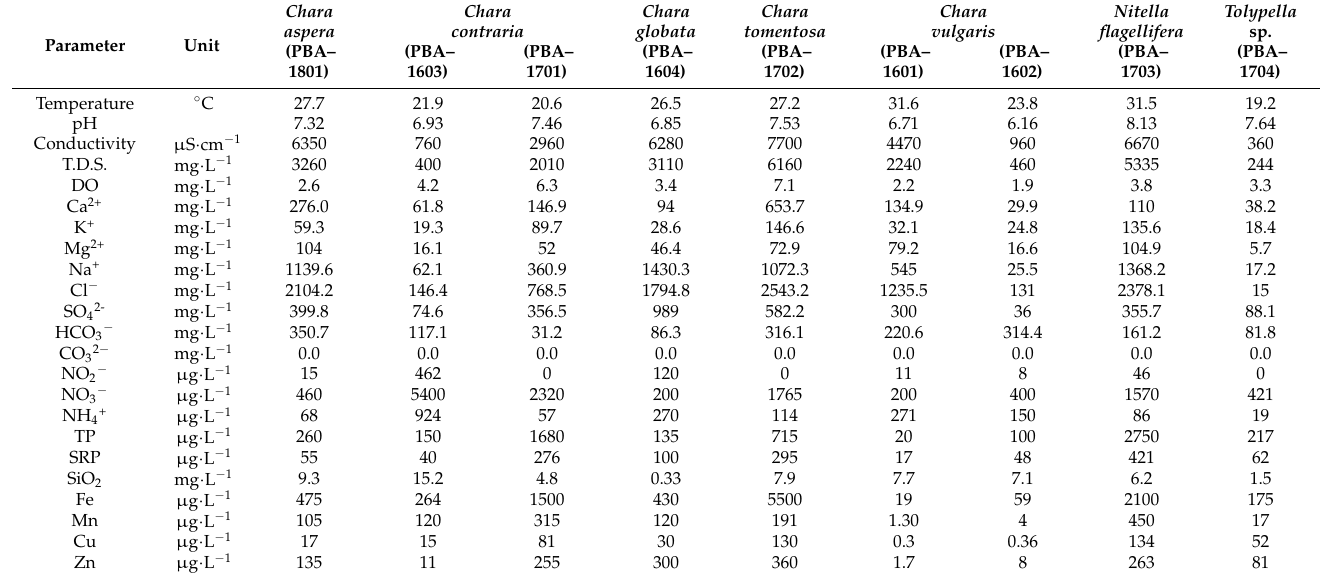
Table 1. Hydrochemical variables of the sampling sites where the charophyte specimens were collected.